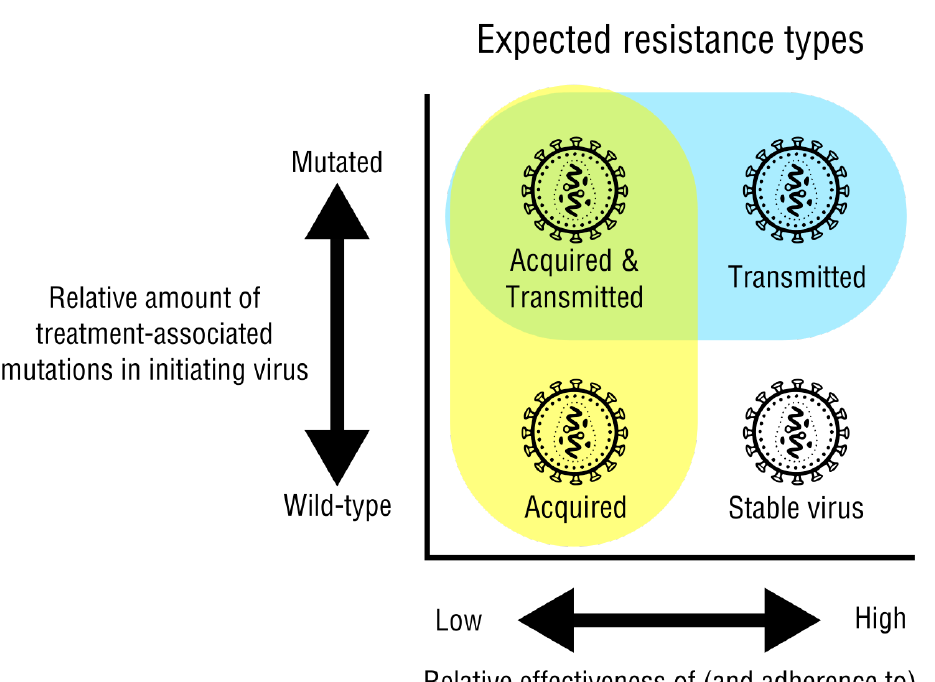
Figure 1. Expected resistance types due to treatment effectiveness and the characteristics of the initiating virus strain. Acquired (yellow) and transmitted (blue) resistance are shown. Viruses that infect as a wild-type are unmutated and highly susceptible to antiretroviral therapy. Ideally, when therapy is effective, this strain would not develop escape mutations and any spread to new hosts would remain susceptible to treatment (lower right). After therapy however, these strains could acquire drug-resistance mutations (ADR, lower left). Viruses that infect after acquiring drug resistance are less susceptible to treatment, potentially acquiring additional mutations if less effective drug combinations are used or adherence is inconsistent (upper left) or spreading with existing mutations to new hosts, referred to as transmitted drug resistance (TDR, upper right). Pre-exposure prophylaxis would also be most effective against wild-type